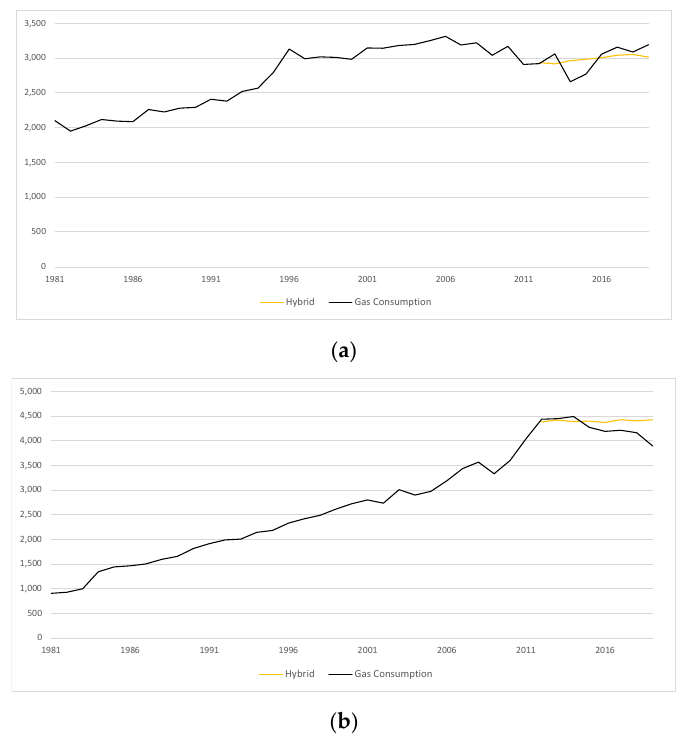
Figure 4. Natural gas consumption [TJ]–actual values and forecasts: ( a ) Germany; ( b ) Japan.